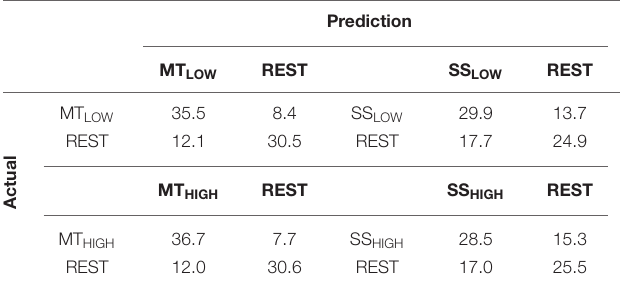
TABLE 3 | Confusion matrices summarizing the classification performance of the four regular classifiers (RC) using alpha band features averaged over all subjects ( n = 13).